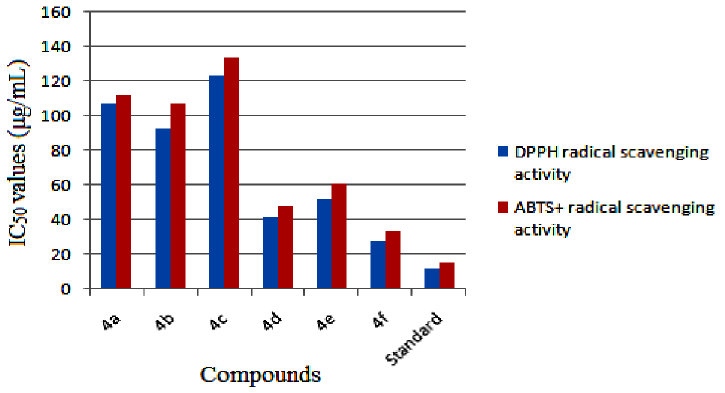
Figure 9. IC (concentration required for 50% inhibition) values for DPPH and ABTS + 50 radical scavenging activities of the compounds 4(a – f) in comparison with the standard antioxidant BHT.